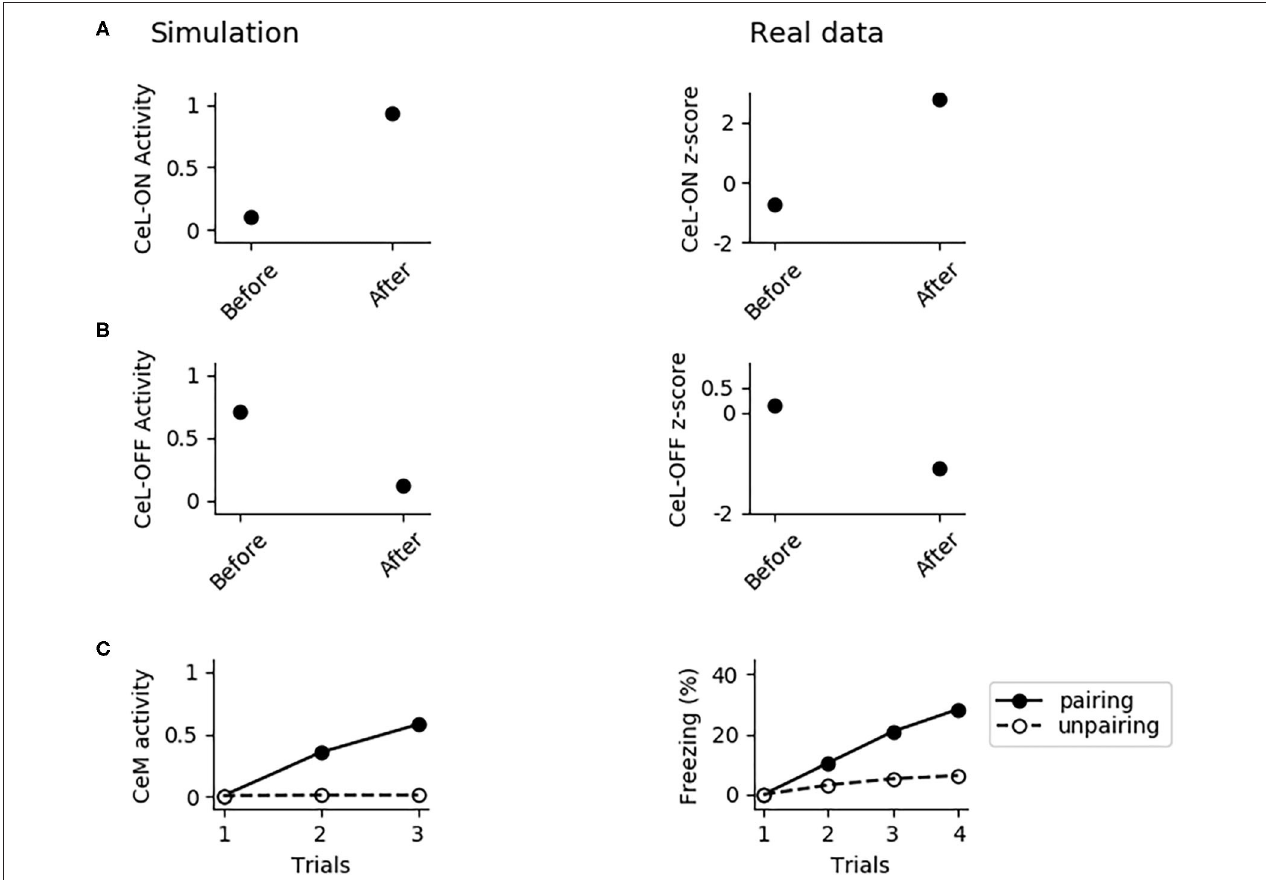
FIGURE 8 | The involvement of CeL in conditioning. (A) Activity of CeL-ON and (B) CeL-OFF when the CS is delivered before and after conditioning, and comparison with data from Ciocchi et al. (2010). (C) CeM activity during the CS delivery in the three trials of conditioning, when the CS is paired with a maximum depolarization of PLp1 and PLp2; we used a similar protocol as control where we unpaired the CS and depolarization.